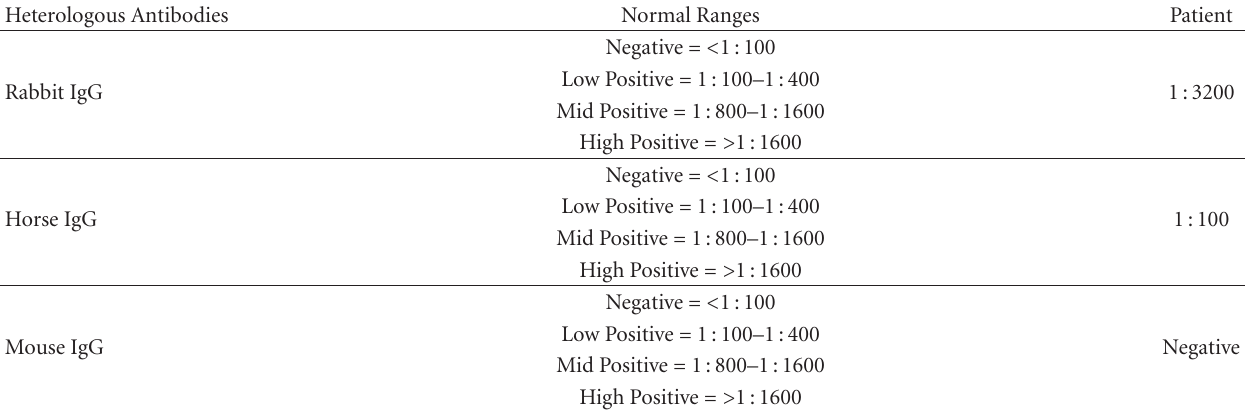
Table 4: Quantitative heterologous antibody